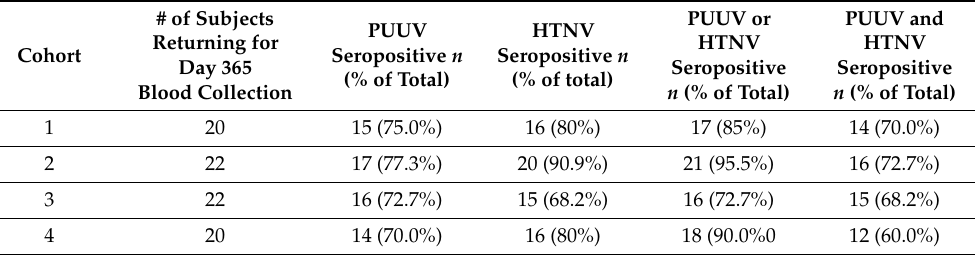
Table 3. Durability of the neutralizing antibody response.